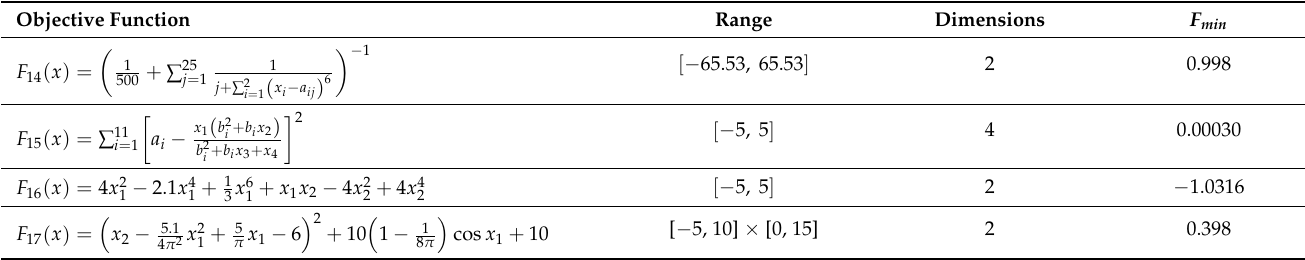
Table A3. Information of fixed-dimensional multimodal